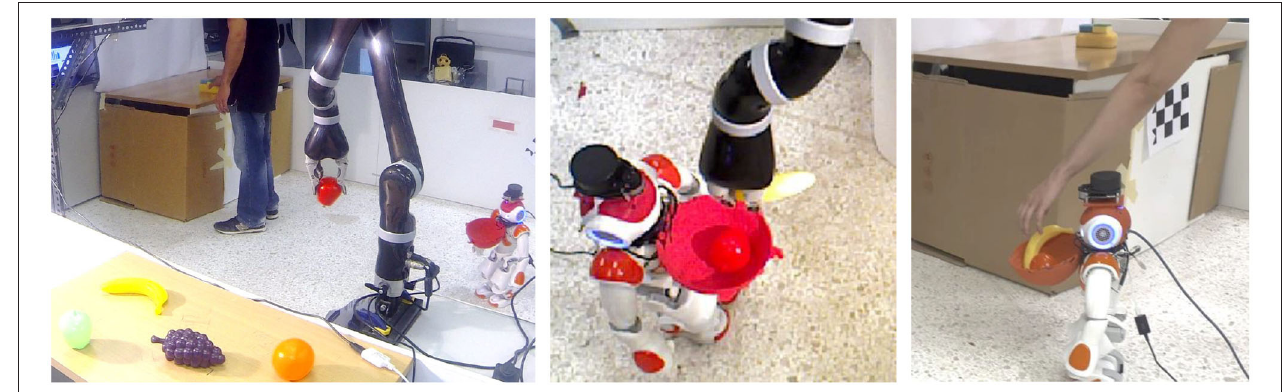
FIGURE 1 | The human-robot-robot “breakfast preparation” collaborative evaluation